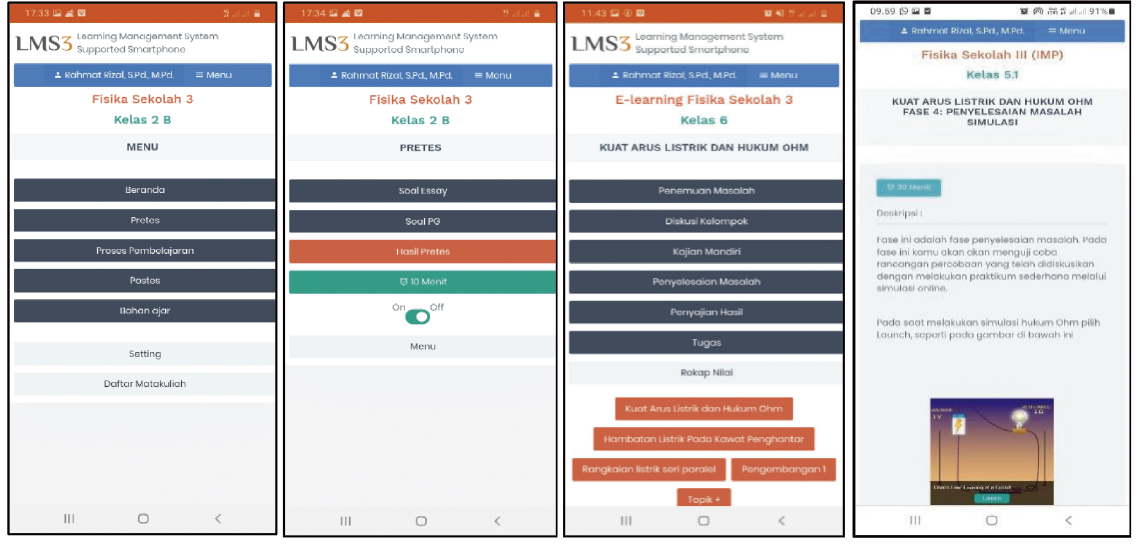
Figure 2. The example of the page display of LMS3